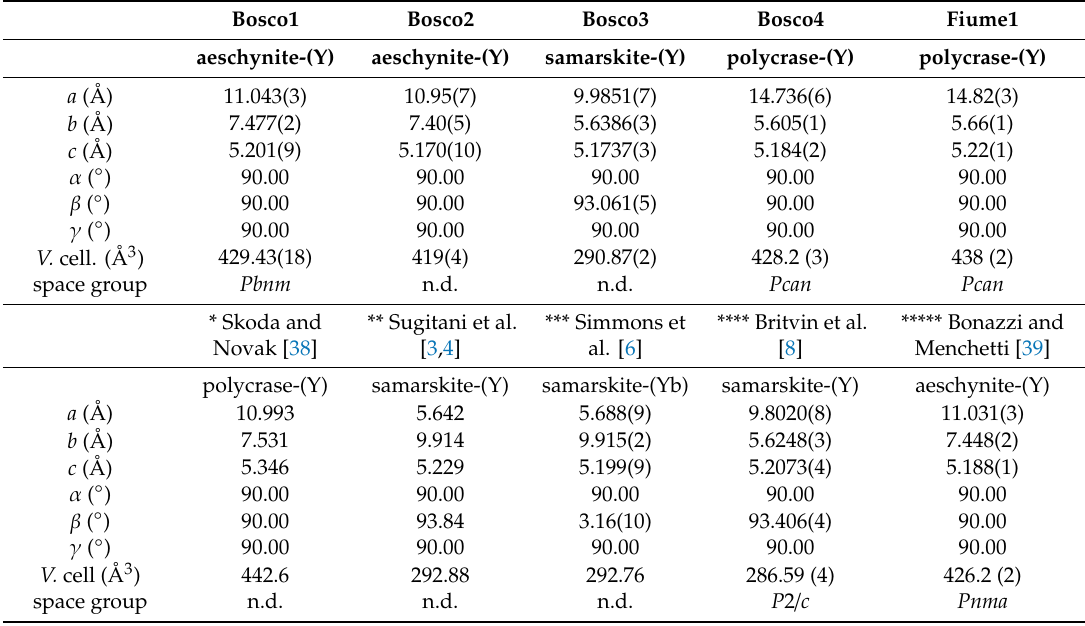
Table 3. Unit-cell parameters, obtained by single-crystal X-ray di ff raction at room temperature, of aeschynite-(Y), polycrase-(Y), and samarskite-(Y) from Bosco and Fiume pegmatites at